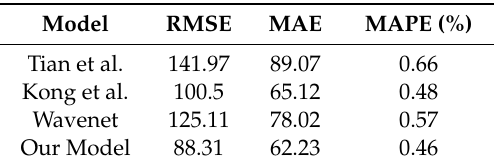
Table 5. Forecasting result obtained using Independent System Operator New England (ISO-NE) testing dataset 2.